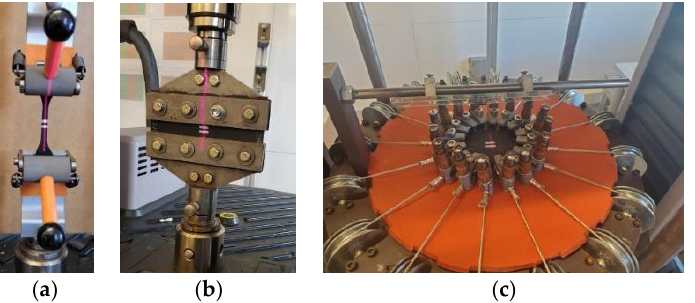
Figure 7. Experimental coupon testing setup: ( a ) uniaxial test, ( b ) planar test, and ( c ) equibiaxial test.